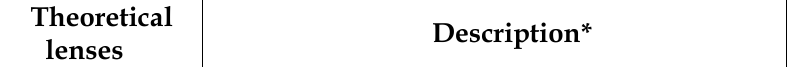
Table 10: Main theoretical lense